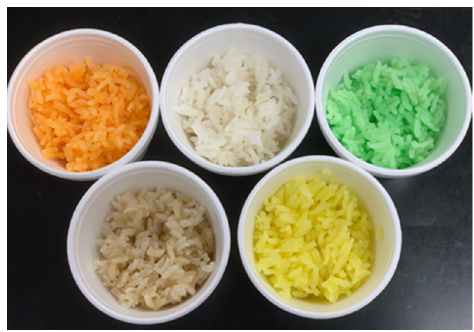
Figure 1. Cooked rice samples used in this study. Four test samples (in a clockwise direction from the top left corner: orange, white, green, and yellow) and one filler (in the bottom left corner: brown) were served.